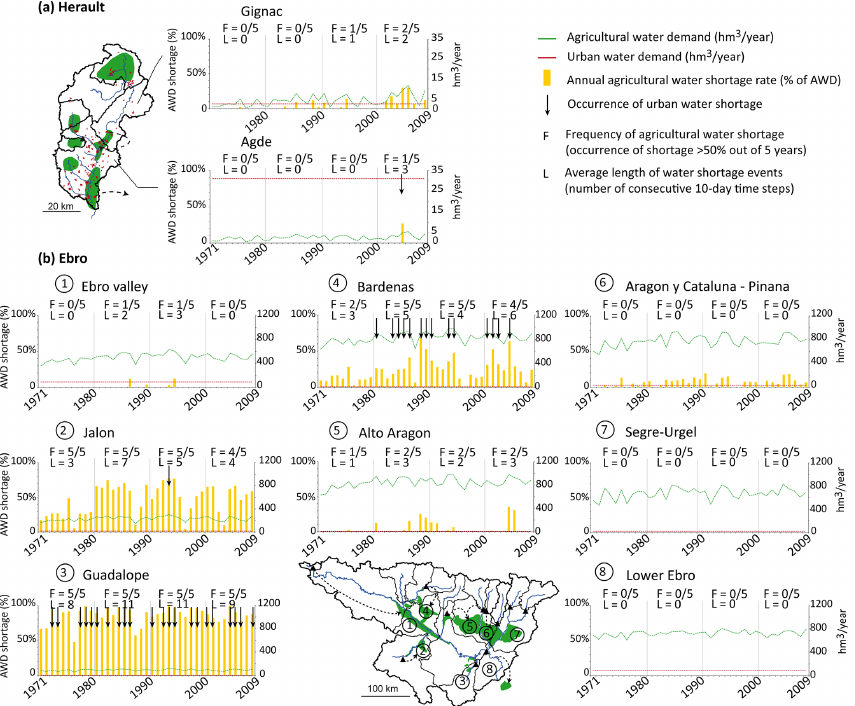
Figure 11. Frequency and intensity of agricultural and urban water shortage under current water uses (2009) and hydro-climatic conditions in the period 1971–2009 (a) in the Hérault Basin and (b) in the Ebro